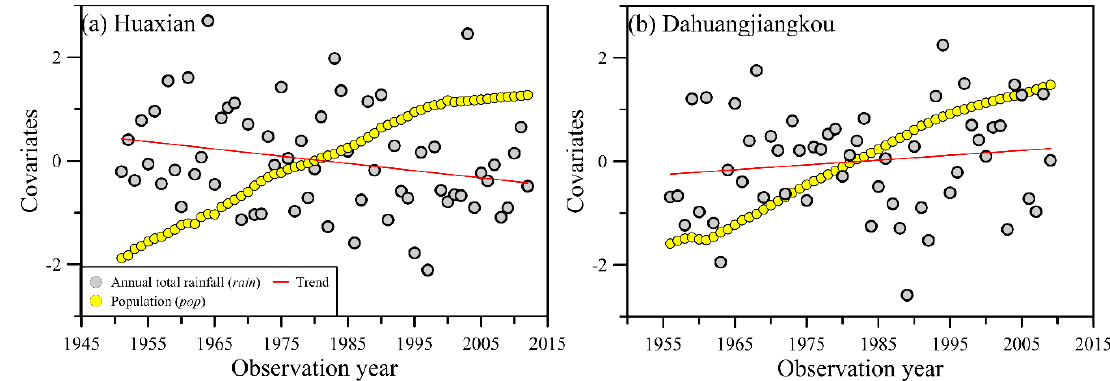
Figure 3. Time series of the standardized pop and rain covariates for ( a ) Huaxian and ( b ) Dahuangjiangkou stations.